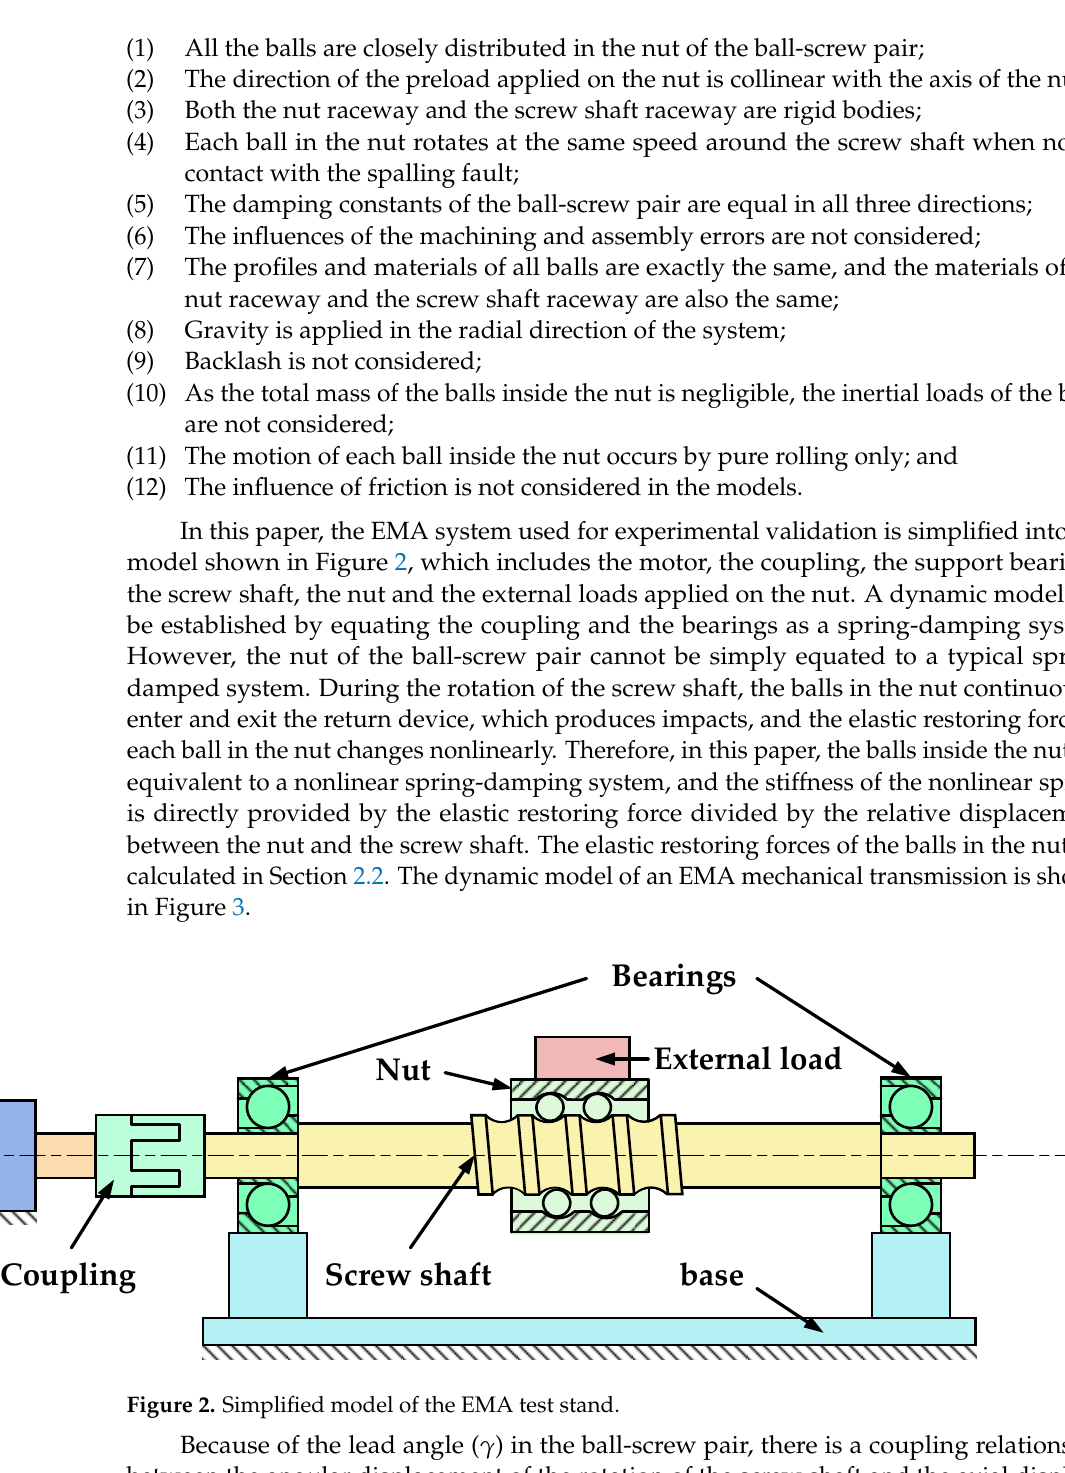
Figure 3. Dynamic model of an EMA mechanical transmission. ( a ) Axial model; ( b ) radial model. According to Newton’s second law, the motion equation of an EMA mechanical part can be expressed as: